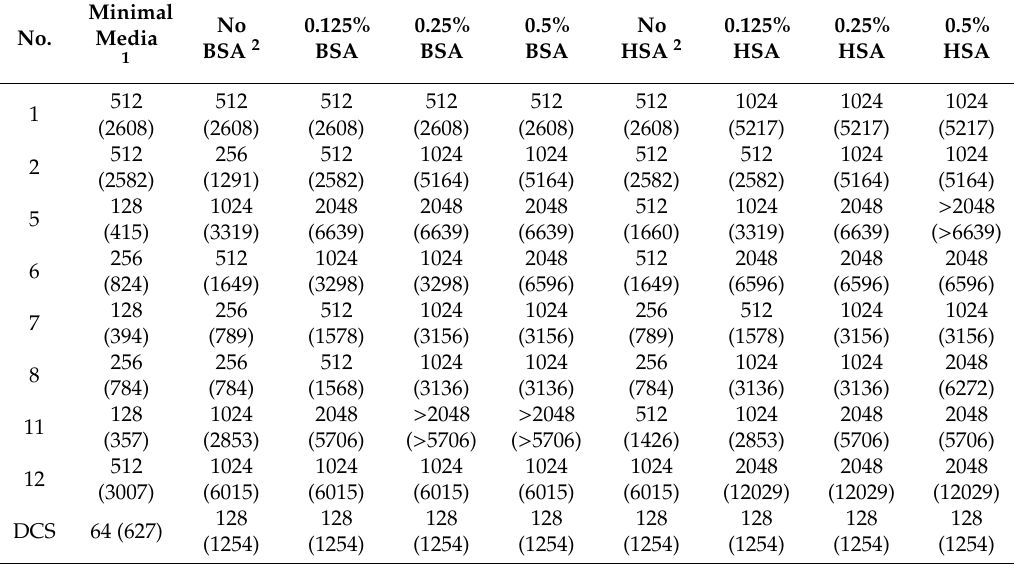
Table 2. Minimal inhibitory concentration (MIC) values [ µ g / ml ( µ M)] against Mycobacterium smegmatis (Msm) with and without bovine serum albumin (BSA) and human serum albumin (HSA) at day 4.